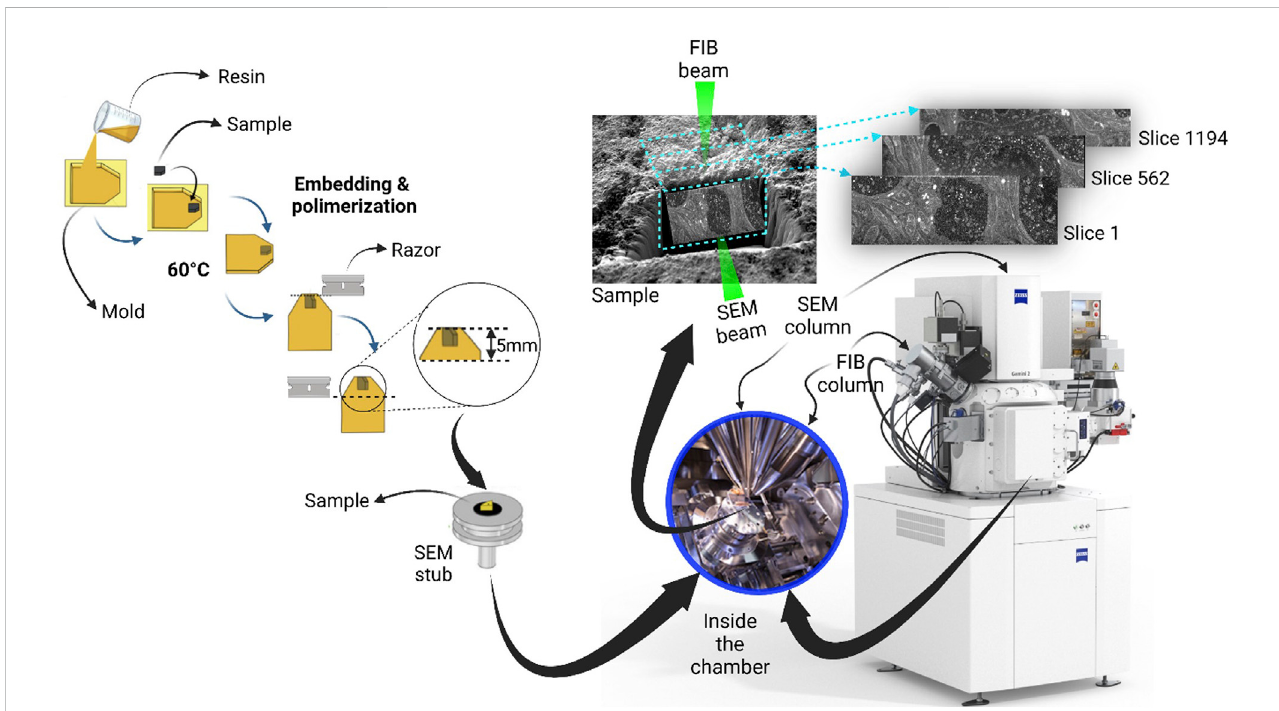
FIGURE 2 Work fl ow of sample preparation for focused ion beam milling and SEM imaging process, under a dual beam electron microscope. The ion source (FIB) and the electron source (SEM) are arranged at an angle (54 ° ), allowing the ion beam (Ga+) to remove material from the surface of the specimen, so that the scanning electron beam can make it visible. As a result, a trench (light blue) is generated, thus making the specimen ’ s interior visible. As shown, the exposed surface is parallel to the plane of the ion beam and angled (54 ° ) to the electron